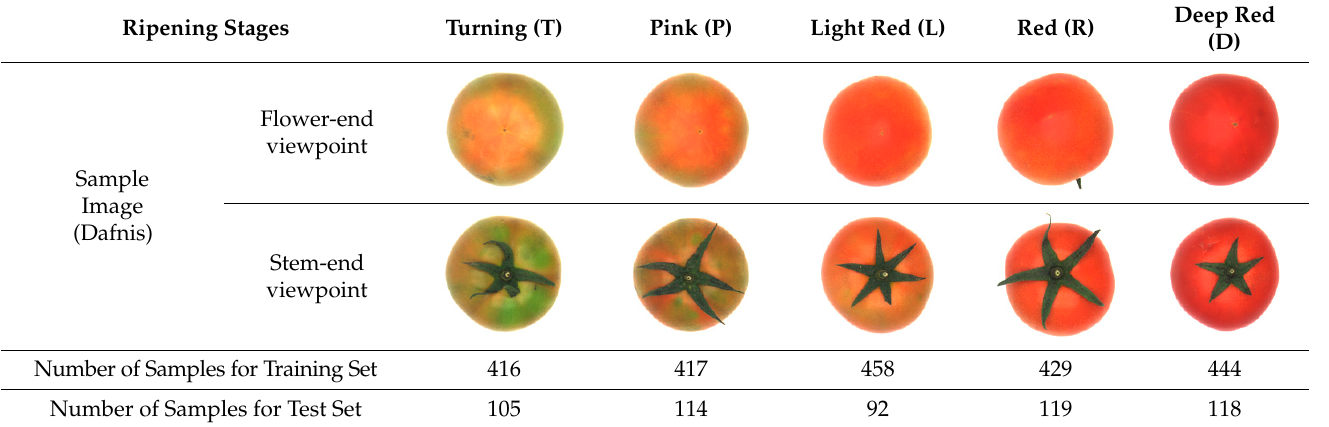
Table 1. The number of tomato samples used for model training and ripeness detection sets.